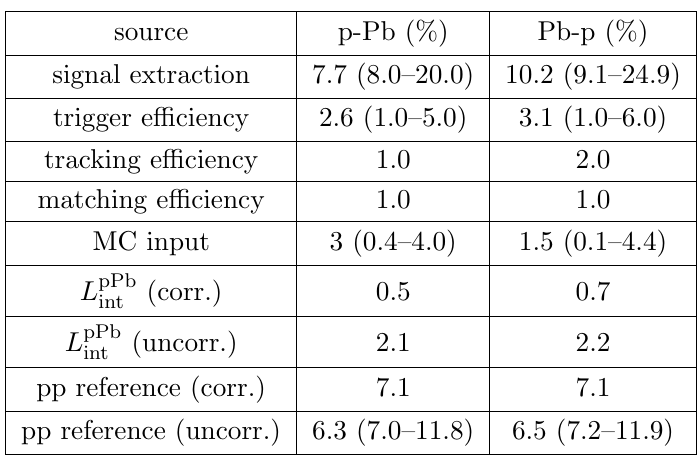
Table 1 . Systematic uncertainties on the determination of the (2S) cross sections times branching ratio and nuclear modi(cid:12)cation factors, shown separately for the p-Pb and Pb-p con(cid:12)gurations. When a single value is quoted, it refers to quantities that have no p T or y cms dependence. In the other cases, the number outside parentheses is for integrated quantities, while the ranges in parentheses indicate the variation of the systematic uncertainties in the p T and y cms